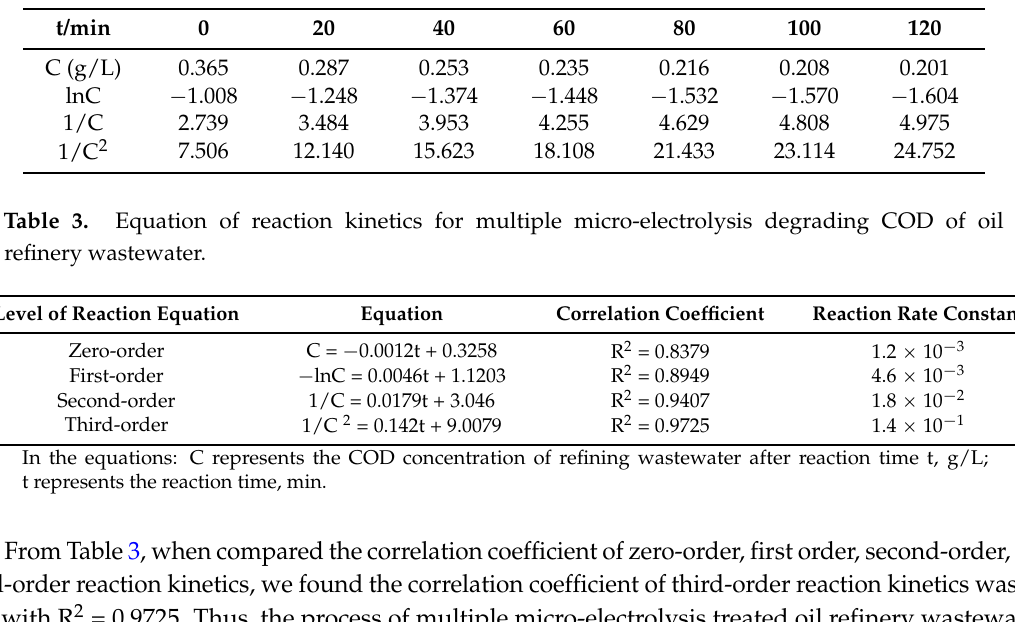
Table 2. The concentration of COD of oil refinery wastewater at different times.